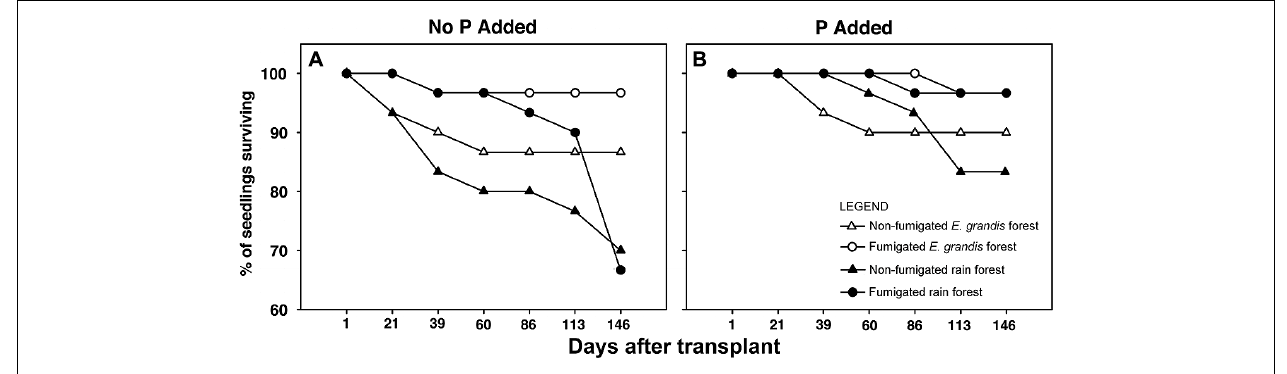
FIGURE 1 | Percentage of Eucalyptus grandis seedlings surviving when grown with no phosphorus (P) added (A) or with phosphorus added (B) versus days after transplant (DAT). P addition began 86 DAT. Percentage survival is based on 30 replicate plants in each treatment.